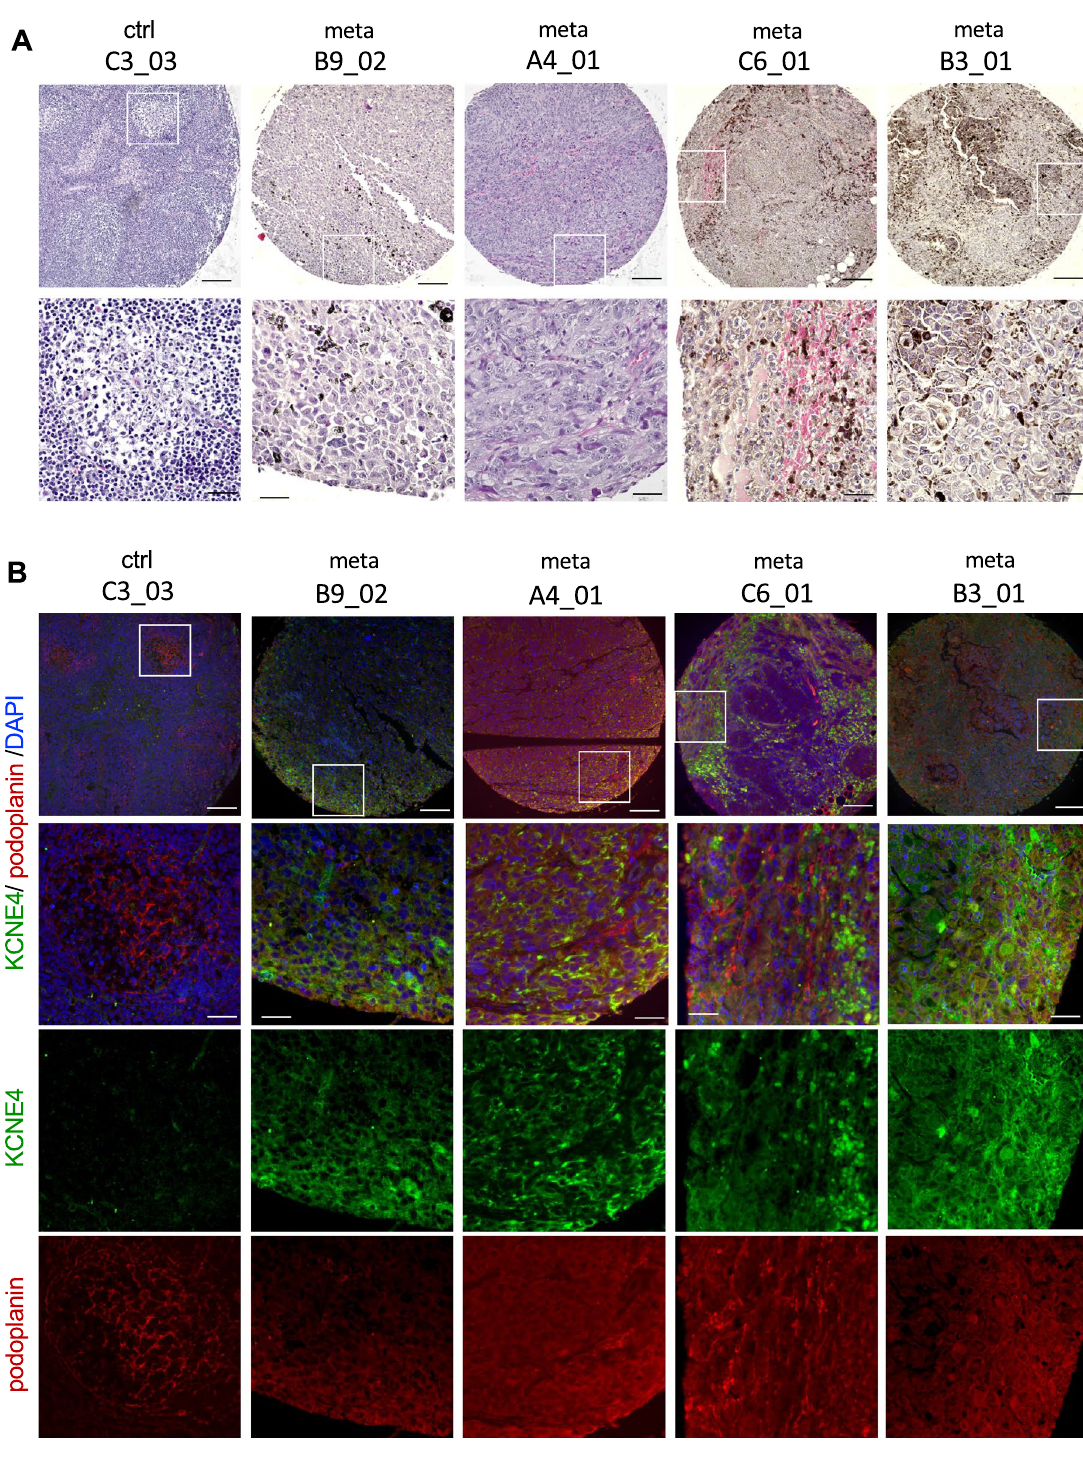
Figure 6. Expression of KCNE4 in human melanoma lymph node metastasis. ( A ) HE staining of human LNs with melanoma metastasis. ( B ) Human LNs were examined by immunostaining using anti-KCNE4 and anti- podoplanin antibodies. ctrl C3_03; normal LN. meta B9_02, A4_01, C6_01 and B3_01: metastatic malignant melanoma from the neck, groin, and neck and groin, respectively. Nuclei were stained with DAPI. Bars: 200 µm and 50